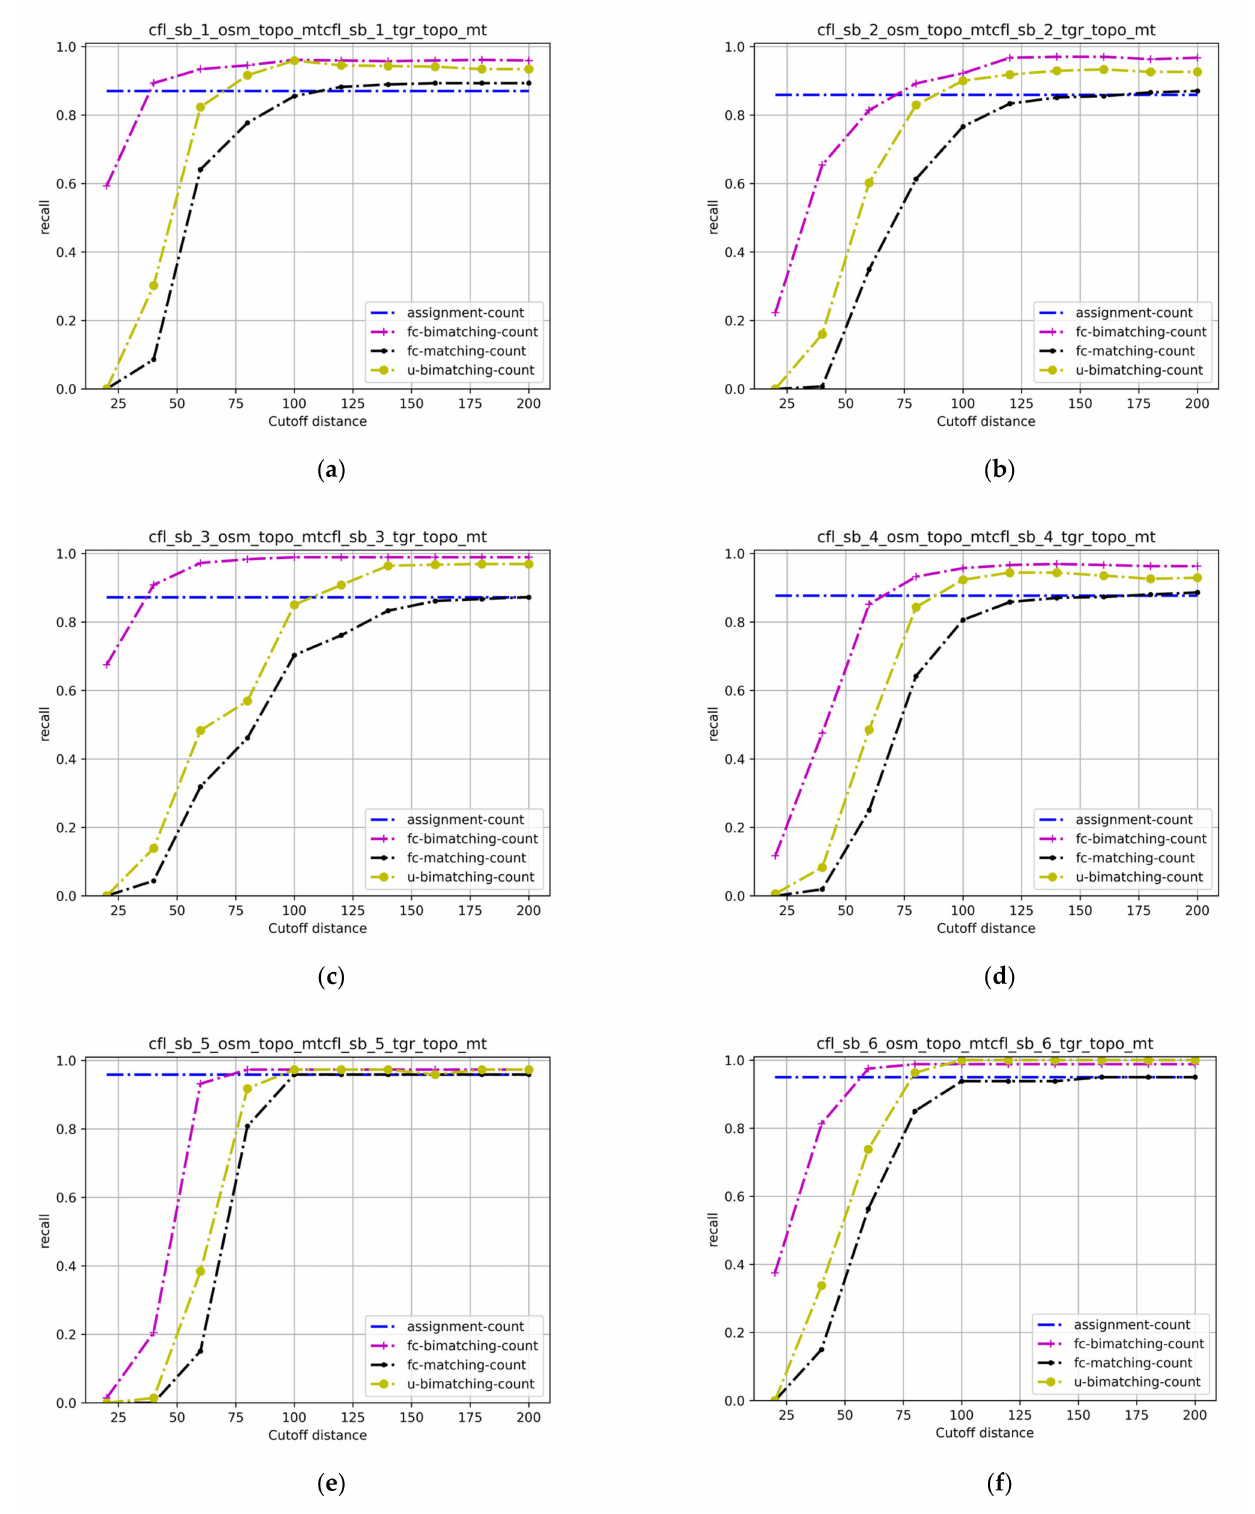
Figure 5. Recall rates of optimized conflation models for the Santa Barbara dataset (OSM vs. TIGER). ( a – f ) Results for sites #1 through